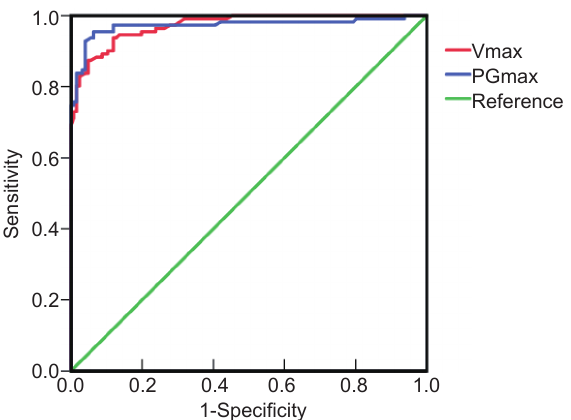
Figure 2 ROC of Vmax (red line) and PGmax (blue line) for determining IJV regional stenosis. Green line is a reference